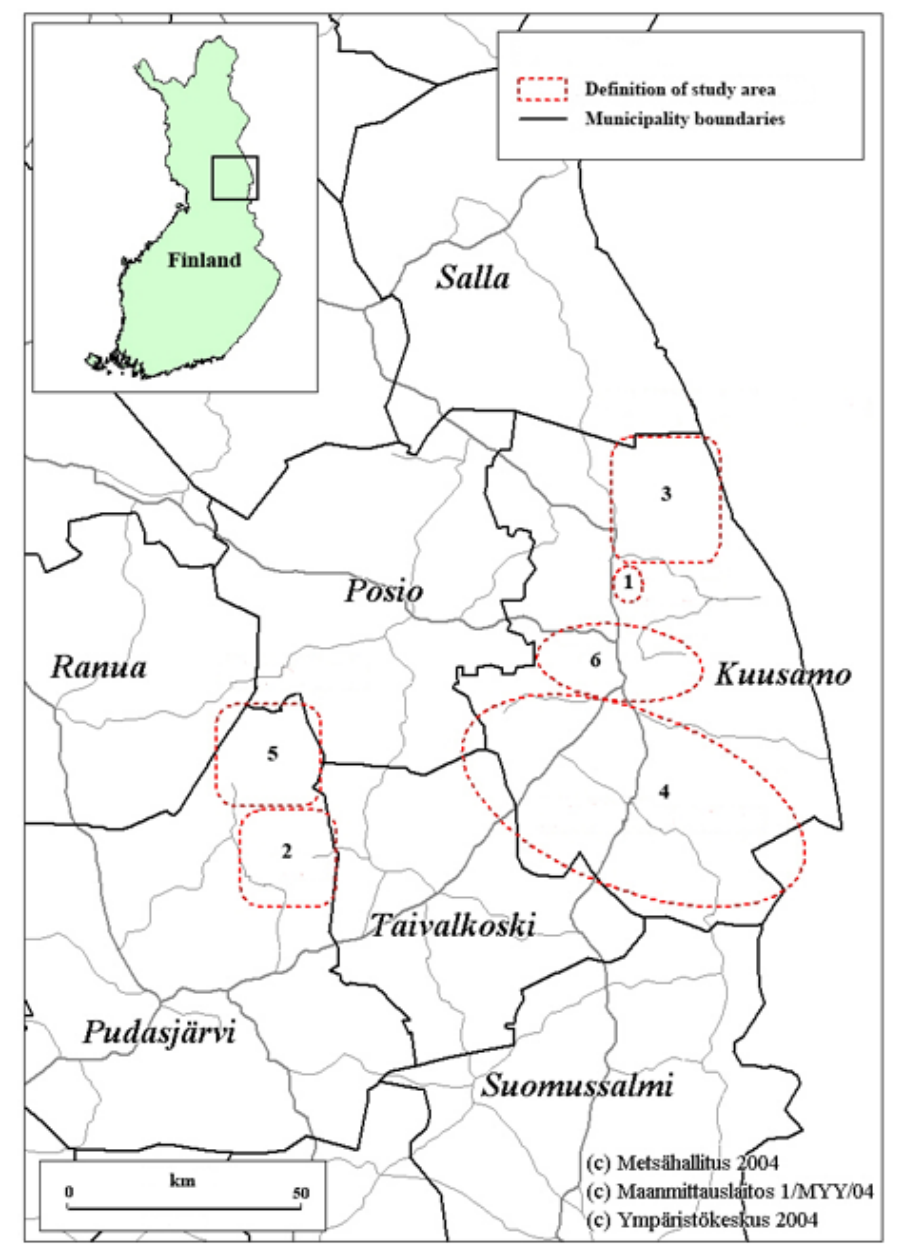
Fig. 2 . Study areas: (1) the Ruka tourist resort; (2) the Syötekylä tourist resort; (3) northern Kuusamo, which is near a conservation area; (4) southern Kuusamo, which is near a conservation area; (5) Sarajärvi, which is near a conservation area; and (6) downtown